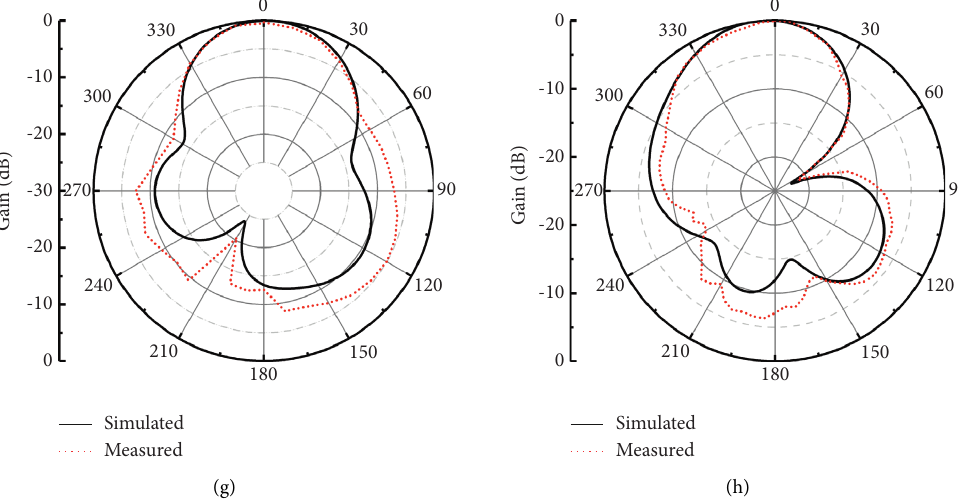
Figure 6: Comparison between simulation and measurement. (a) S-parameters, (b) AR, (c) gain, and (d) S12. At 4.5GHz, dextrally polarized radiation is normalized in the (e) XOZ and YOZ (f) planes and left-handed polarized radiation is normalized in the (g) XOZ and (h) YOZ